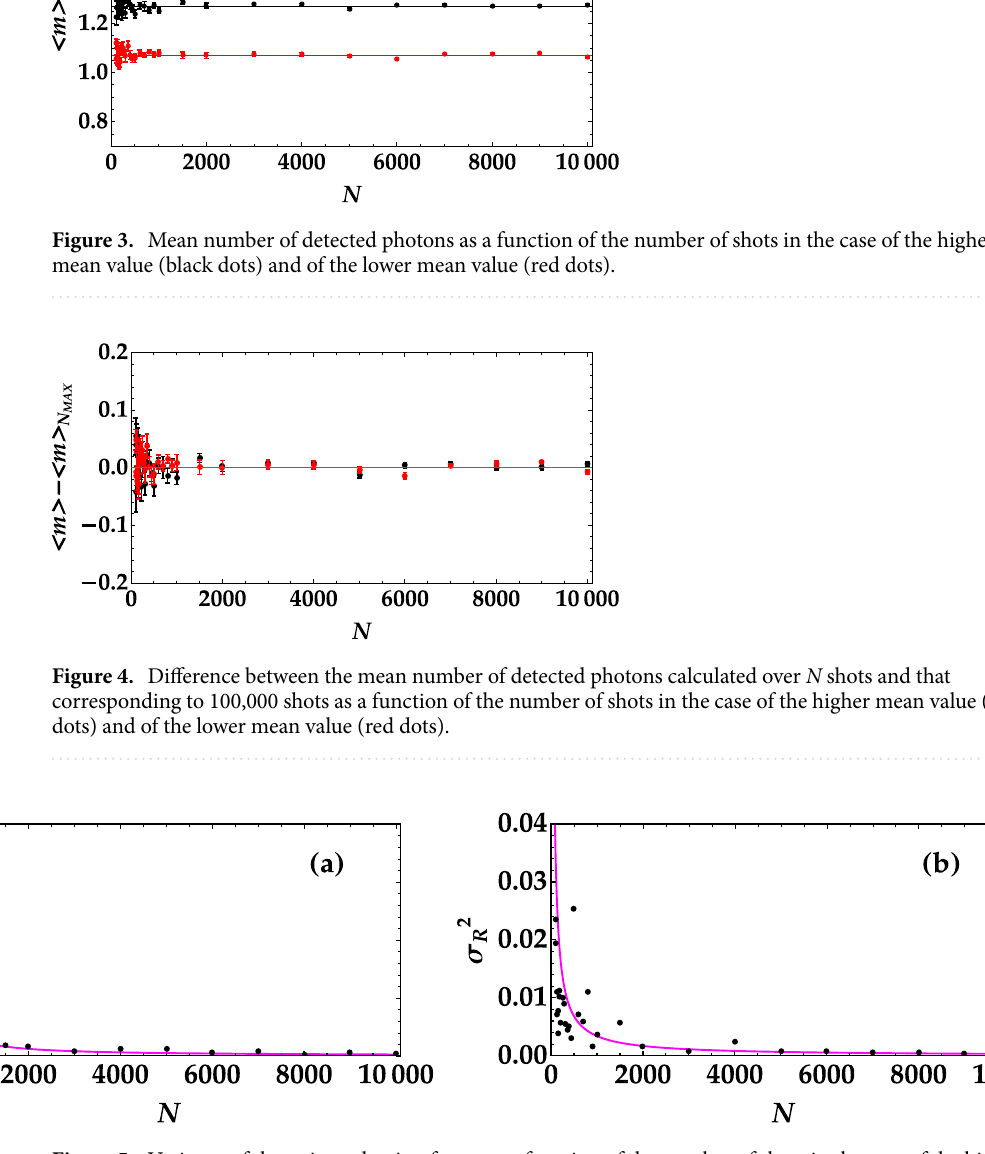
2.4 0.3 in ( a ) and a 3.4 0.8 in ( b ), which is valid in the case a / x , with a = = ± = ±